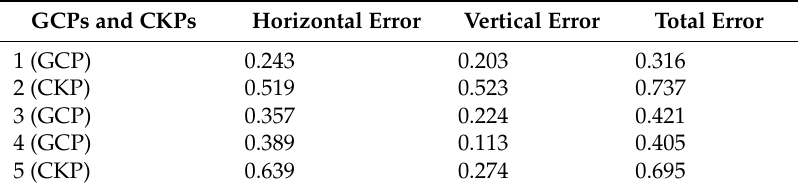
Table 4. Absolute accuracy (GCPs errors) of DOMs in